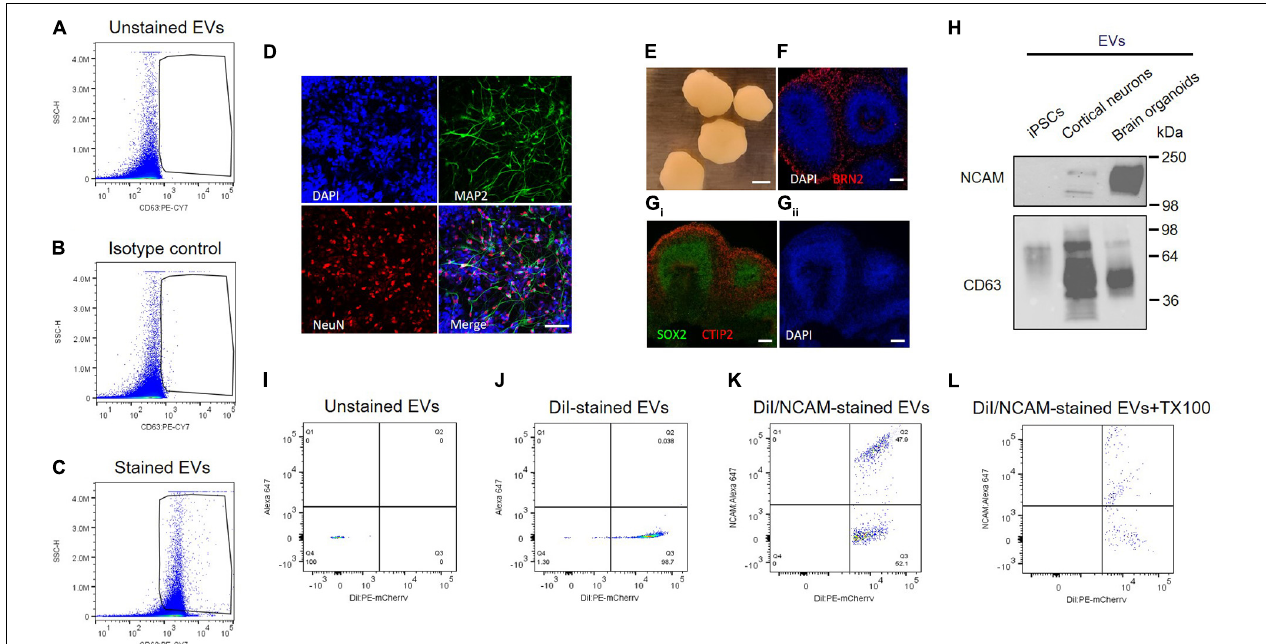
FIGURE 5 | NCAM as a neuronal exosome marker in plasma. (A–C) Quantitative analysis of plasma EVs using flow cytometry. Dot plots of fluorescent intensity for plasma EVs stained with PE-CY7-labeled CD63 antibody. EVs were unstained (A) and stained with either isotype control (B) or CD63 antibody (C) . (D) A18945 iPSC-derived neurons cultured for 6 weeks and immunostaining with mature neuronal markers (DAPI, MAP2, NeuN, and merged image). Images were taken using Zeiss LSM confocal microscope at × 63 magnification. Scale bar, 20 µ m. (E) Representative images of cortical organoids at day 90 of differentiation. Scale bar, 1 mm. (F) The organoids express cortical layer marker BRN2 (also called POU3F2). The nuclei were stained with DAPI. Scale bar, 100 µ m. (G i ) Markers for proliferating neural progenitors (SOX2) and cortical neuron marker CTIP2 (also known as BCL11B) with nuclei DAPI staining (G ii ) . (H) Western blot analysis of NCAM and CD63 from EVs released from iPSCs, iPSC-derived cortical neurons, and iPSC-derived brain organoids. EVs were isolated using SEC from the cell culture media of each sample, and equal EV particle numbers (6 × 10 8 ) were subject to immunoblotting with NCAM and CD63 antibodies. (I–L) Flow cytometry dot plots of fluorescent intensity for plasma EVs double-stained with DiI and NCAM antibody. EV samples were unstained (I) , single stained with DiI (J) , and double-stained with DiI and NCAM antibody in the absence (K) and presence (L) of 0.1% Triton